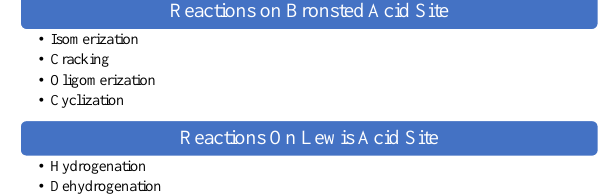
Figure 1: Types of reactions on acid sites of zeolite